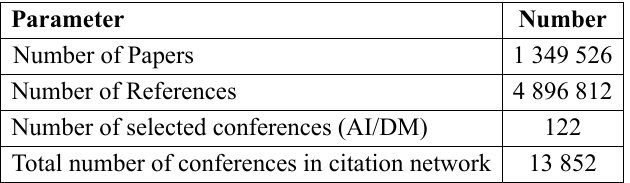
Table 1. Statistics about used data from Microsoft Academic